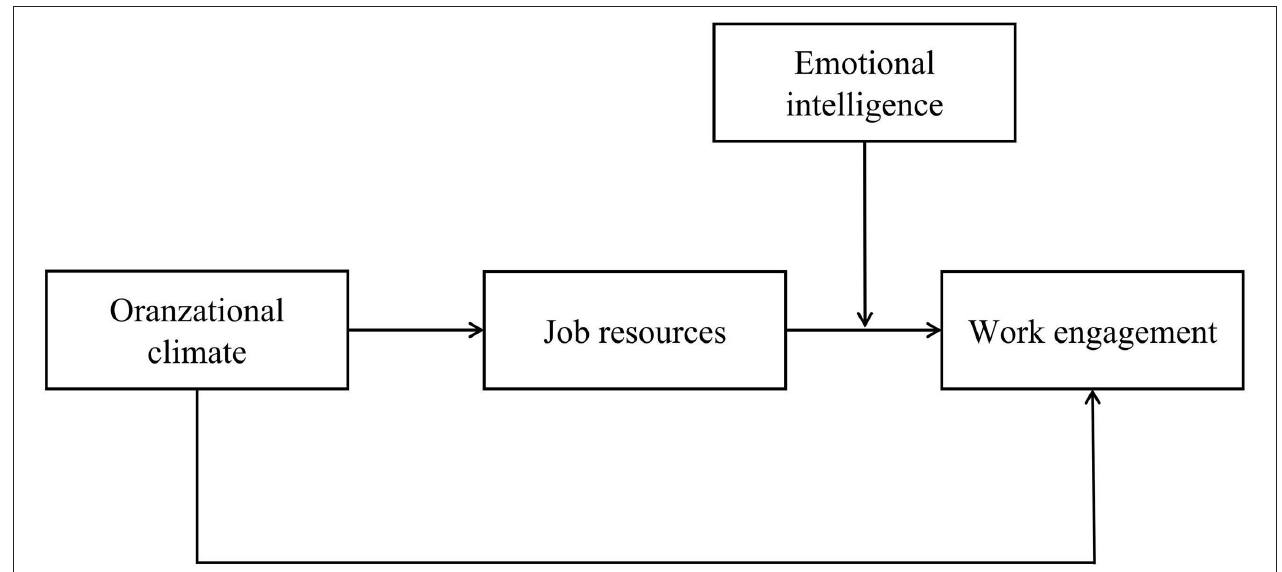
FIGURE 1 | The proposed moderated mediation model.